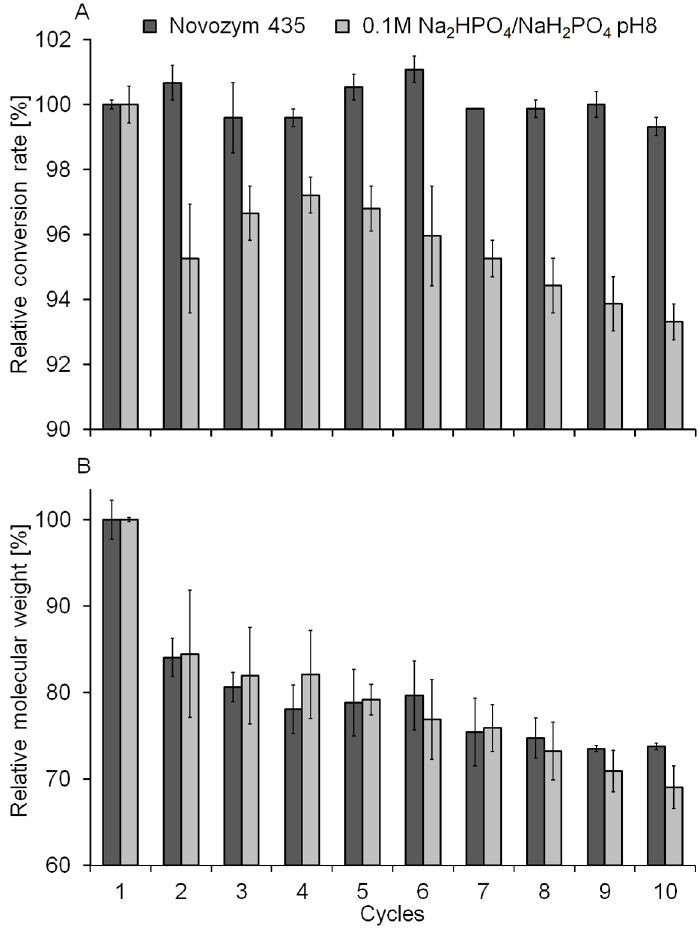
Figure 4. Recyclability of the CaLB immobilized on polypropylene beads (light gray bars) over 10 cycles in polymerization reaction conducted for 4 h, expressed as: ( A ) relative percentage of the reacted monomer; and ( B ) relative molecular weight of the products compared to Novozym 435 (dark grey bars). All experiments were performed in duplicates and are here shown ± the standard deviation.